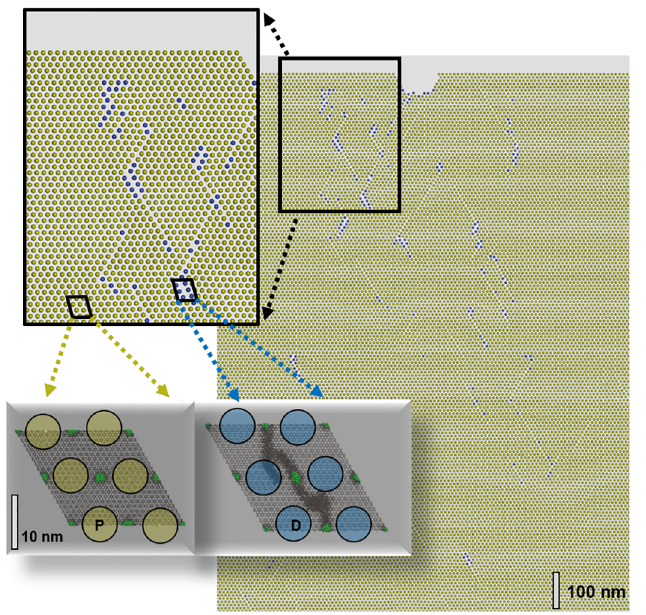
Fig 3. Coarse grained model mimicking the composite material at the μ m scale. Right: scale-up model comprising 90.000 building blocks. The system was loaded by implementing 5% elastic deformation along the horizontal direction. The snapshot was taken 100.000 time-steps after allowing the system to relax. The inset at the lower left illustrates the coarsening of the atomistic model in terms of two only types of building blocks, namely pristine (P) and damaged (D) building blocks, shown in yellow and blue,